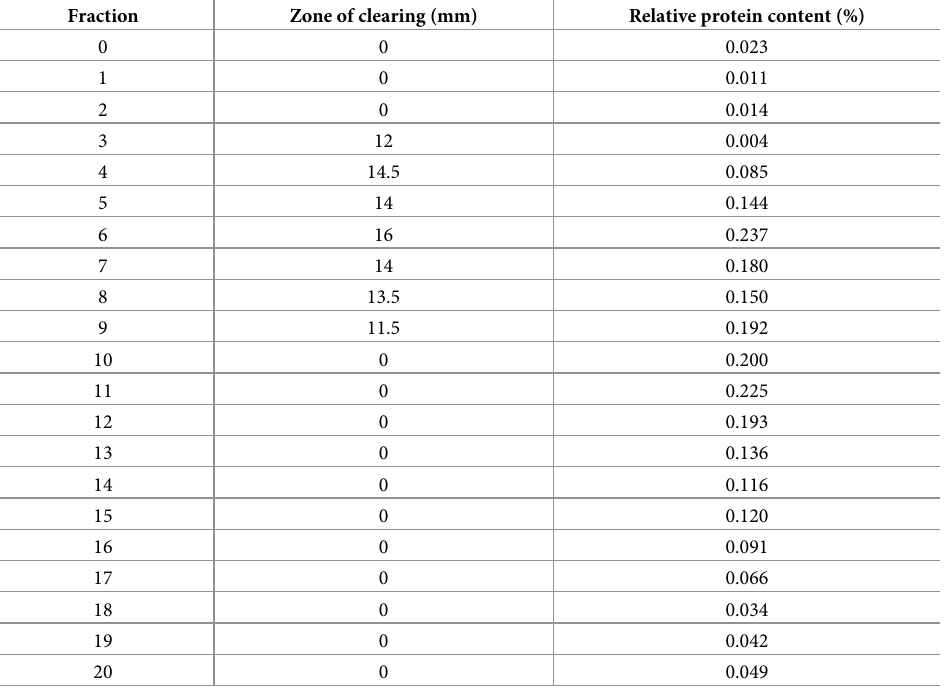
Table 3. Inhibition of C . graminicola measured by disk diffusion of kochia exudates following size fractionation. Fraction Zone of clearing